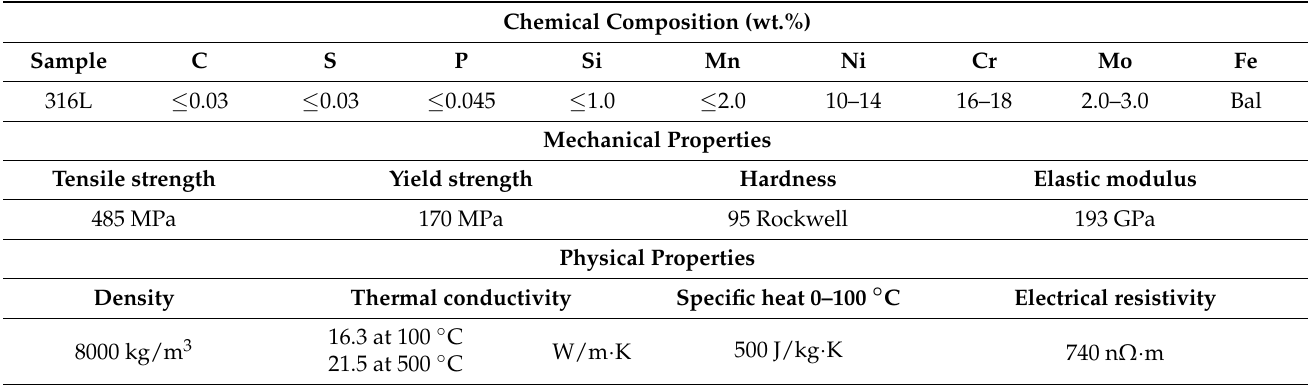
Table 1. Chemical composition of the 316L stainless steel (Wt.%) [17]. Mechanical properties of the 316L stainless steel [28].